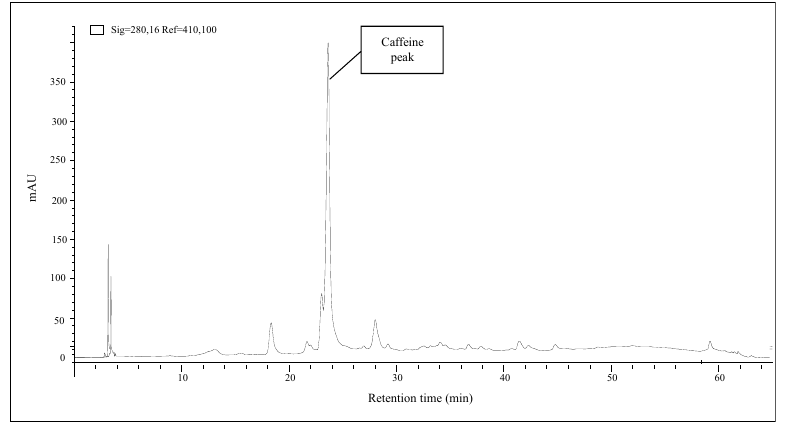
Figure 1. SCG extract chromatogram obtained via HPLC.